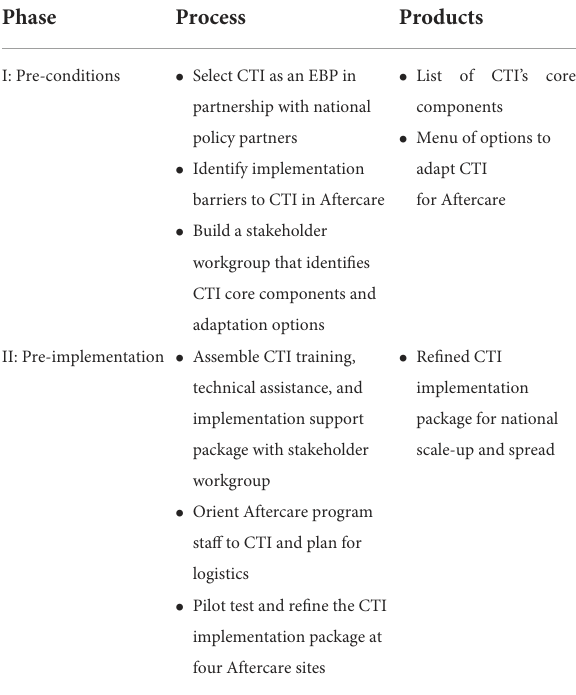
TABLE 1 Phases 1 and 2 of REP specified for a CTI implementation pilot in Aftercare. Phase Process